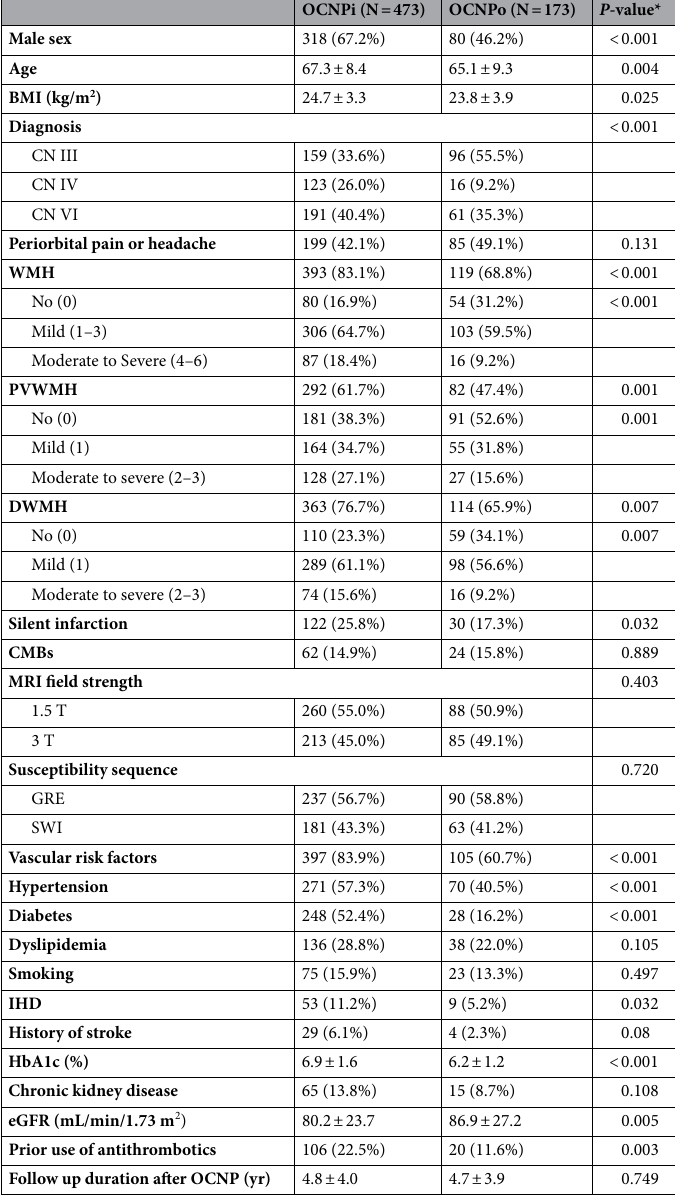
Table 3. Factors associated with ocular cranial nerve palsy of presumed ischemic origin (OCNPi). BMI body mass index, CN cranial nerve, OCNP ocular cranial nerve palsy, WMH white matter